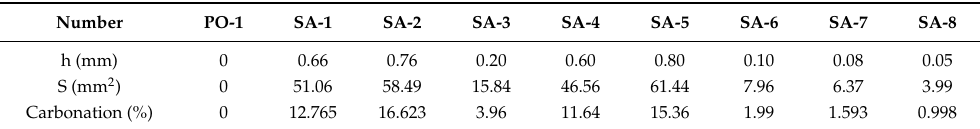
Figure 5. SA-1–SA-8 after carbonation with 1% concentration of phenolphthalein indicator. Table 5. Carbonation depth and carbonation area of PO-1, SA-1–SA-8.